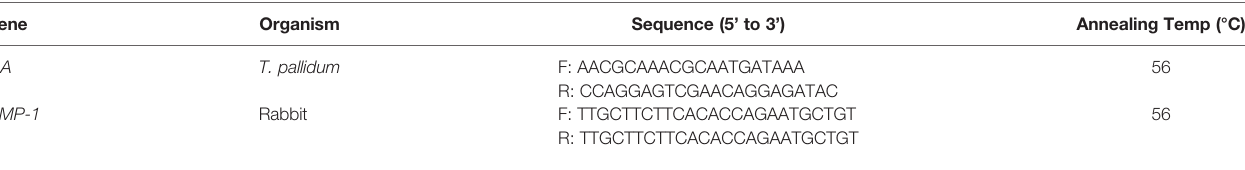
TABLE 1 | Primer sequences used in